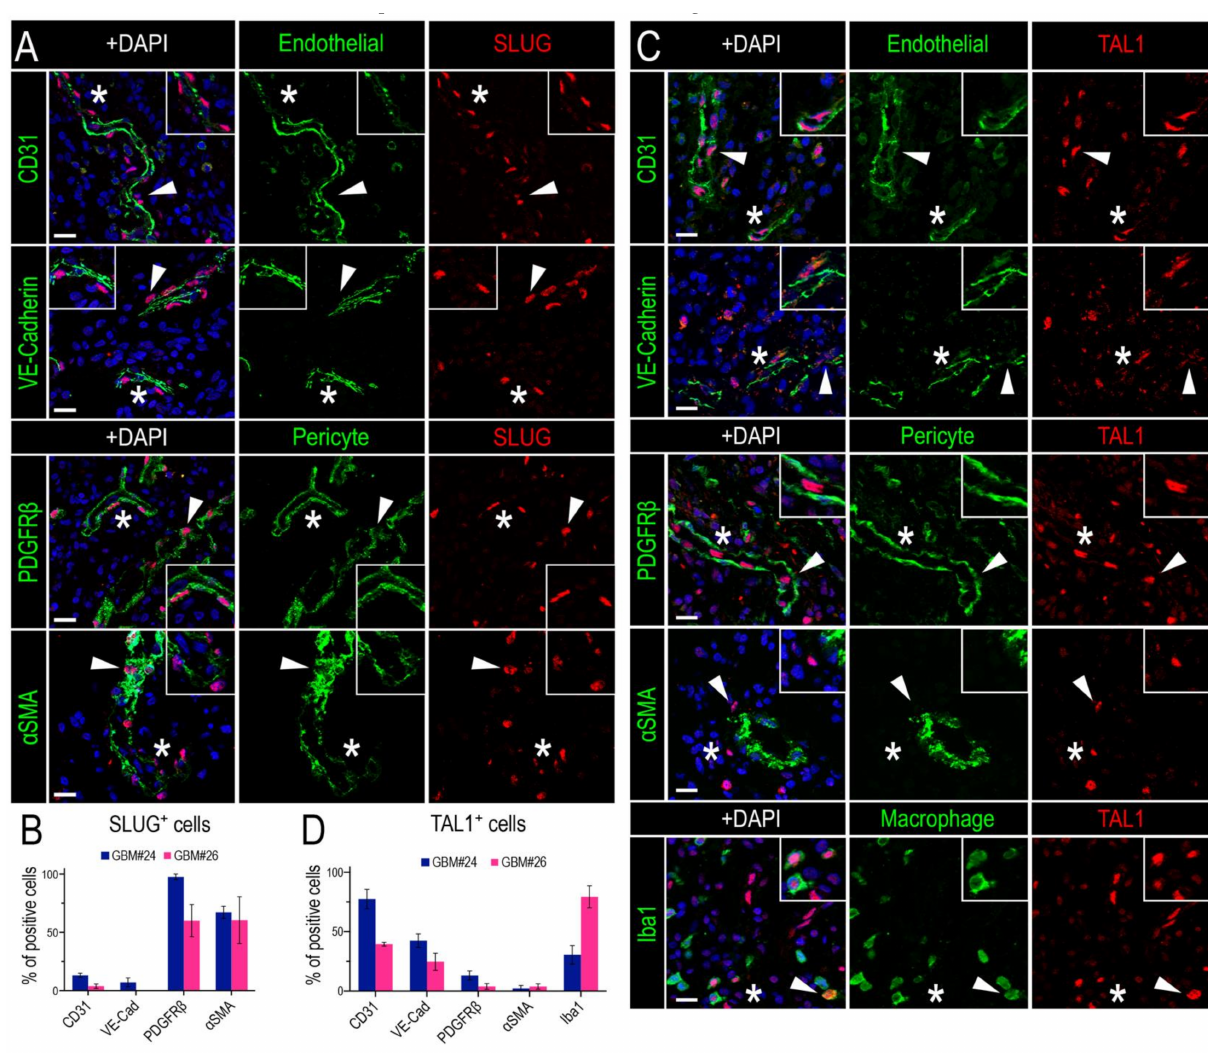
Figure 4. SLUG and TAL1 expression in vascular cells in GBMs. ( A , C ) Representative IF images of either SLUG ( A ) or TAL1 ( C ) co-expression with the endothelial markers CD31 and VE-Cadherin, perivascular/pericyte markers PDGFR β and α SMA, and macrophage/microglial marker Iba1 for TAL1 ( C ) in GBM#24 sample. Arrowheads indicate cells of interest, stars indicate regions of interest magnified in corners of images, altogether showing an expression of SLUG in perivascular cells/pericytes and TAL1 in endothelial cells; scales 20 µ m. ( B , D ) Co-expression quantifications of CD31, VE-Cadherin, PDGFR β , α SMA with SLUG + cells ( B ), and the same markers + Iba1 with TAL1 + cells ( D ) in GBM#24 and #26. A minimum of 100 SLUG + or TAL1 + cells analyzed for each sample and each combination of markers. Double positive cells are represented as % of total SLUG + or TAL1 +